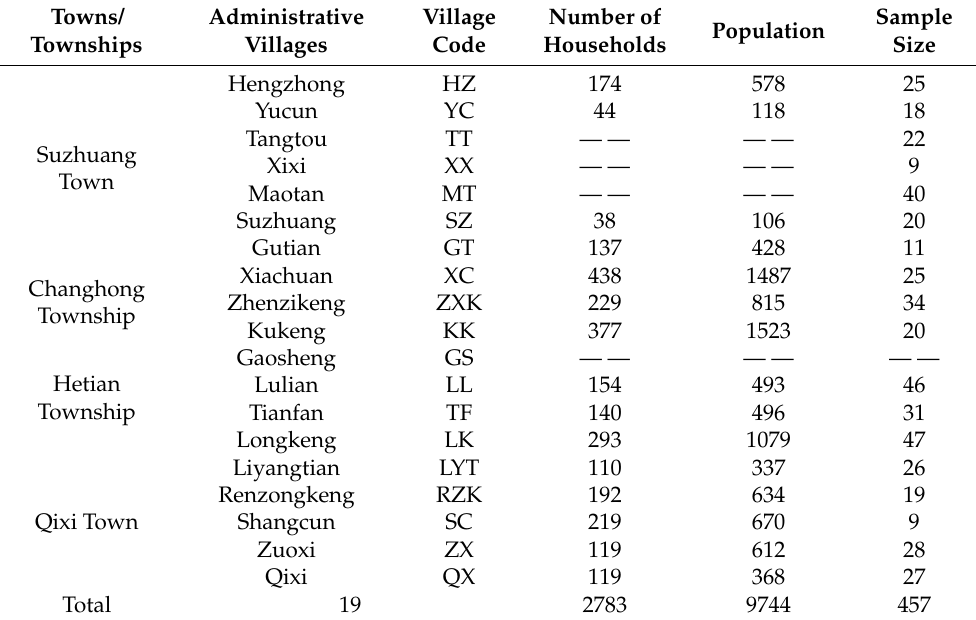
Table 2. Statistics on valid